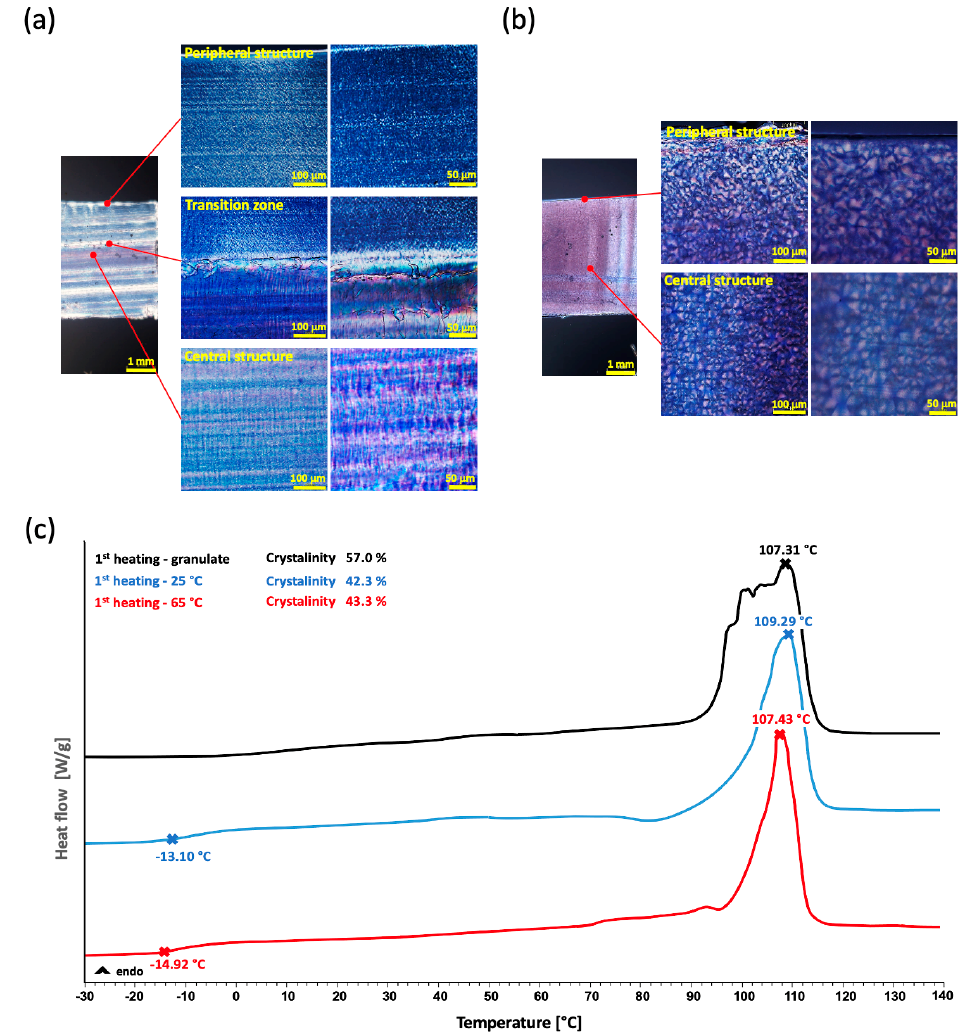
Figure 5. Images of the inner structure analysis: POM images of the inner structure for the 25 °C sample − ( a ), POM images of the inner structure for the 65 °C sample − ( b ) and DSC curves of the 1st heatings of both samples − ( c ).